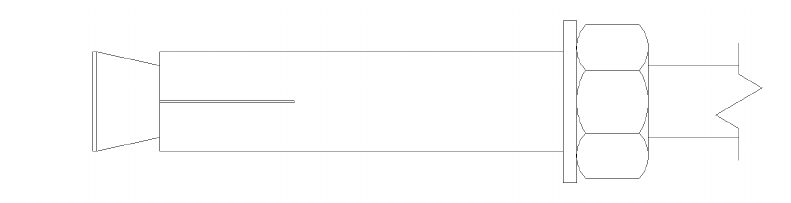
Figure 1. Qualitative representation of the undercut anchor used in the experimental campaign.